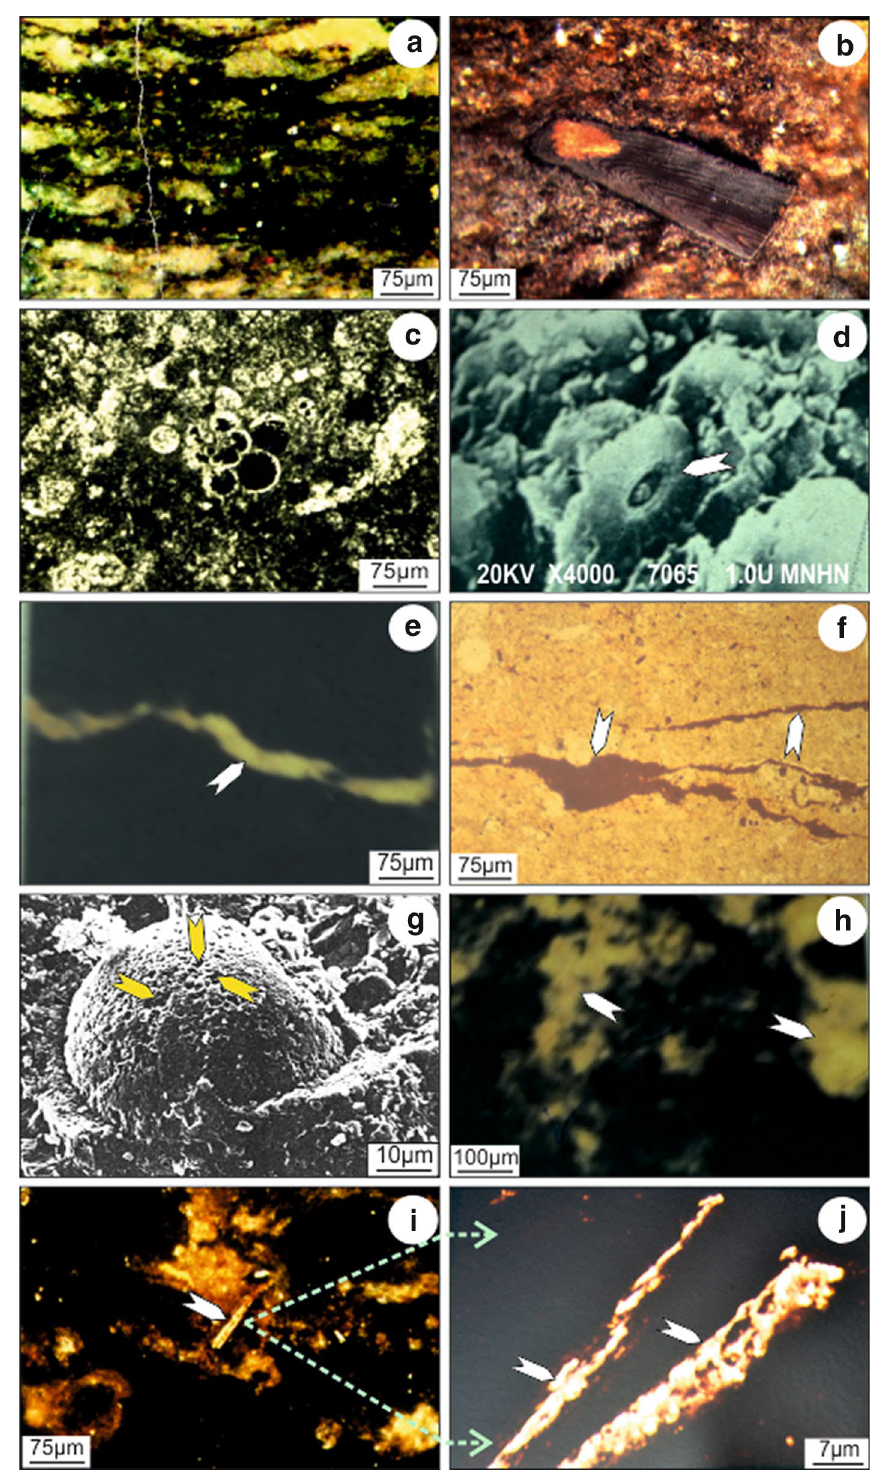
Fig. 3 Organic-rich and organic-lean microfacies and their micro-constituents of Bir M’Cherga Aptian–Albian source rocks (Corel Draw figure exported into jpeg